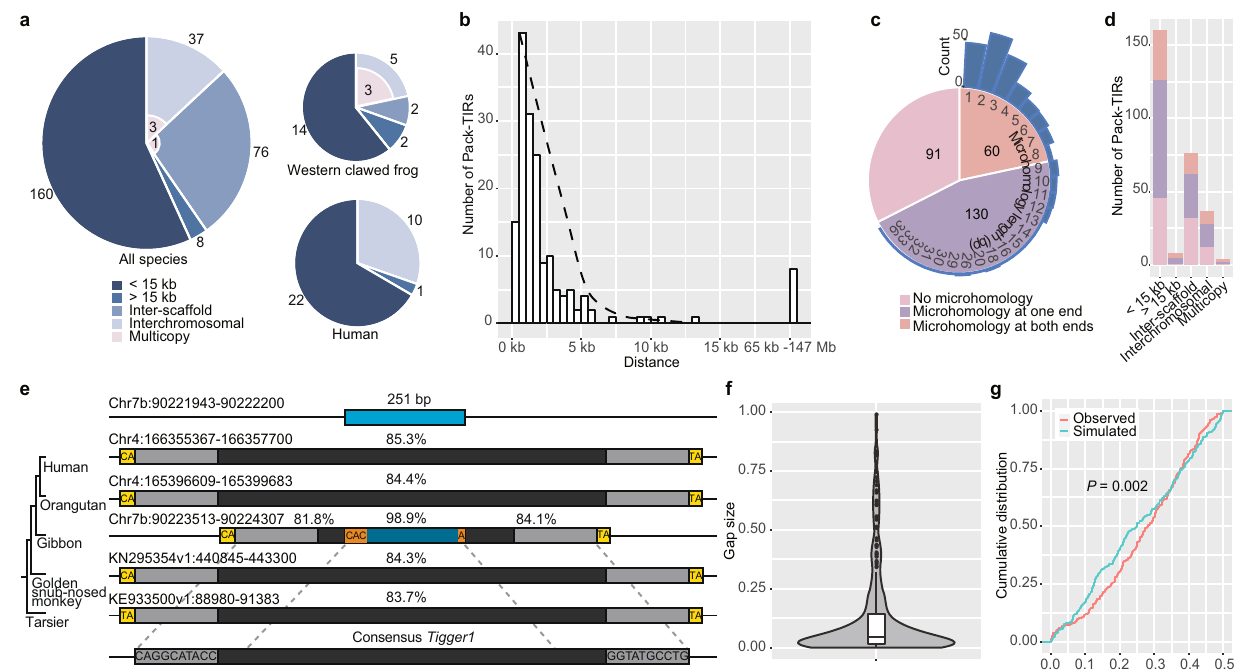
Fig. 2 Evidence supporting the gap- fi lling model for the generation of single-copy Pack-TIRs. a Distribution of Pack-TIRs classi fi ed by distance from their parental copies. The pie charts show the statistics for all species, western clawed frogs, and humans, respectively. Numbers of multicopy Pack-TIRs are highlighted in pink. For example, three out of fi ve interchromosomal Pack-TIRs are multicopy in western clawed frogs. b Histogram of intrachromosomal Pack-TIRs in terms of distance to their parental copies. The dashed curve shows the lowess fi tting result. c Distribution of Pack-TIRs classi fi ed by the presence of microhomology at two breakpoints. The sidebar shows the histogram of the microhomology length. d Distribution of Pack-TIRs with respect to the microhomology presence at breakpoints. Single-copy Pack-TIRs close or far from parental copies and multicopy Pack-TIRs are separately counted. e A comparative view of a demo Pack-TIR in gibbons (case #144 in Supplementary Data 1). To simplify, in addition to gibbons, only four phylogenetically representative primates are shown. The fi gure convention follows Fig. 1d except that the microhomology is marked in orange. Note that the left TSD was mutated from TA to CA in the ancestor of humans and monkeys. f Proportion of each gap ( n = 281 samples) relative to the corresponding consensus TE. The distribution is shown as a violin plot: the box indicates the median (middle line) and the interquartile range (IQR, box limits); outliers are beyond 1.5 times IQR; and the violin curve indicates the probability density of the data. g Cumulative density distribution of the observed and simulated relative positions of breakpoints to consensus TEs. Values closer to 0.5 at X -axis indicate positions closer to the middle of the TEs, whereas values close to 0 indicate positions closer to the terminals. The two-sided Kolmogorov-Smirnov test was used to calculate the P